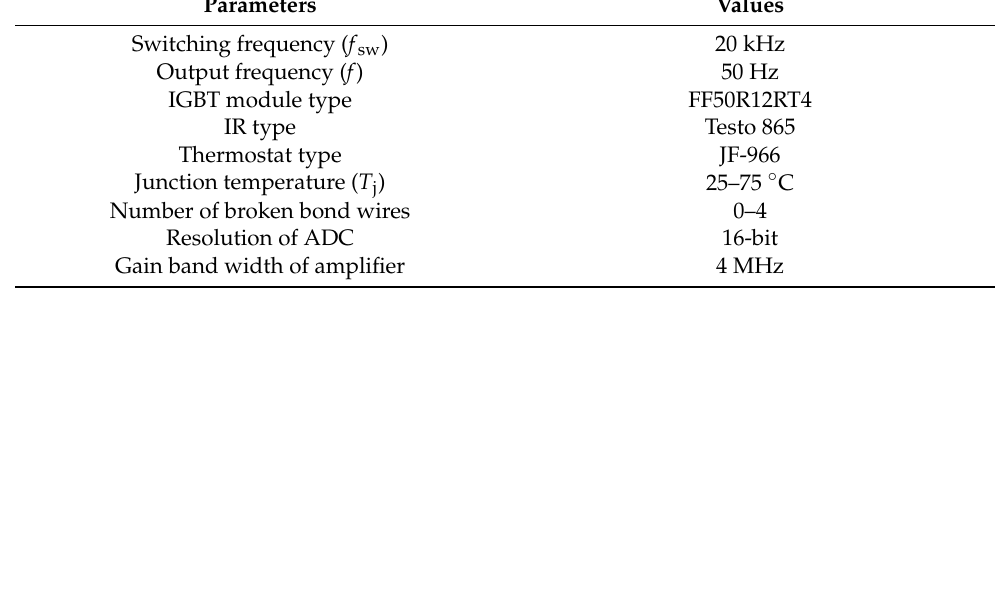
Figure 5. Aging monitoring platform.